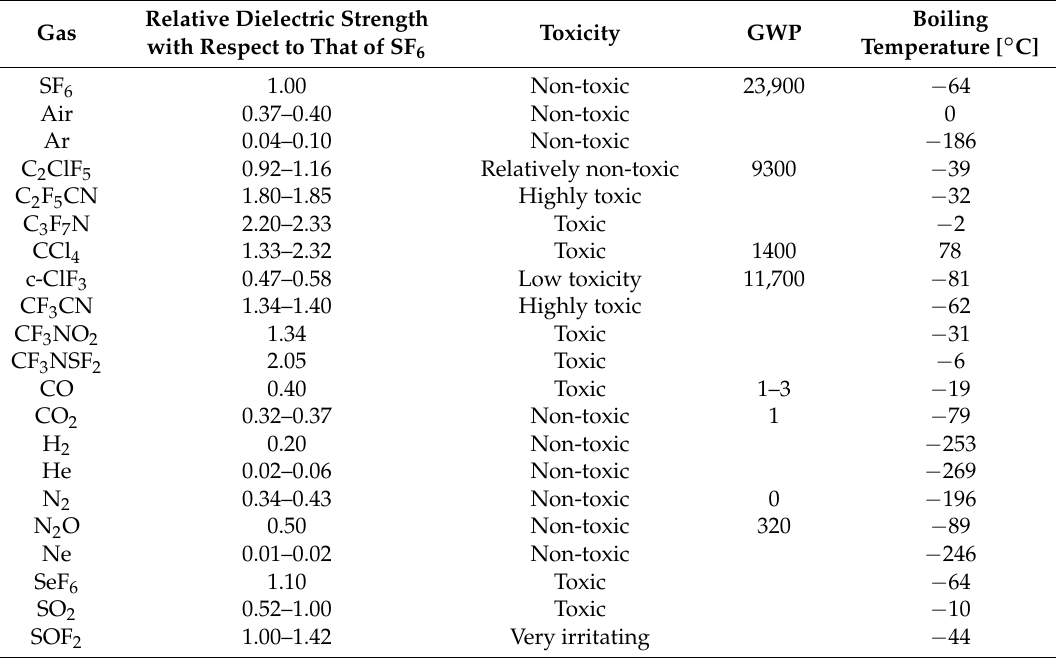
Table 4. Some properties of other selected gases